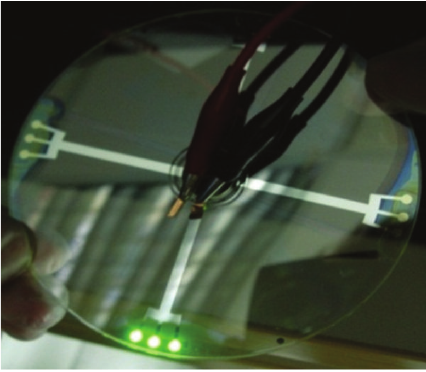
Figure 5: Configuration of the microfluidic channels.